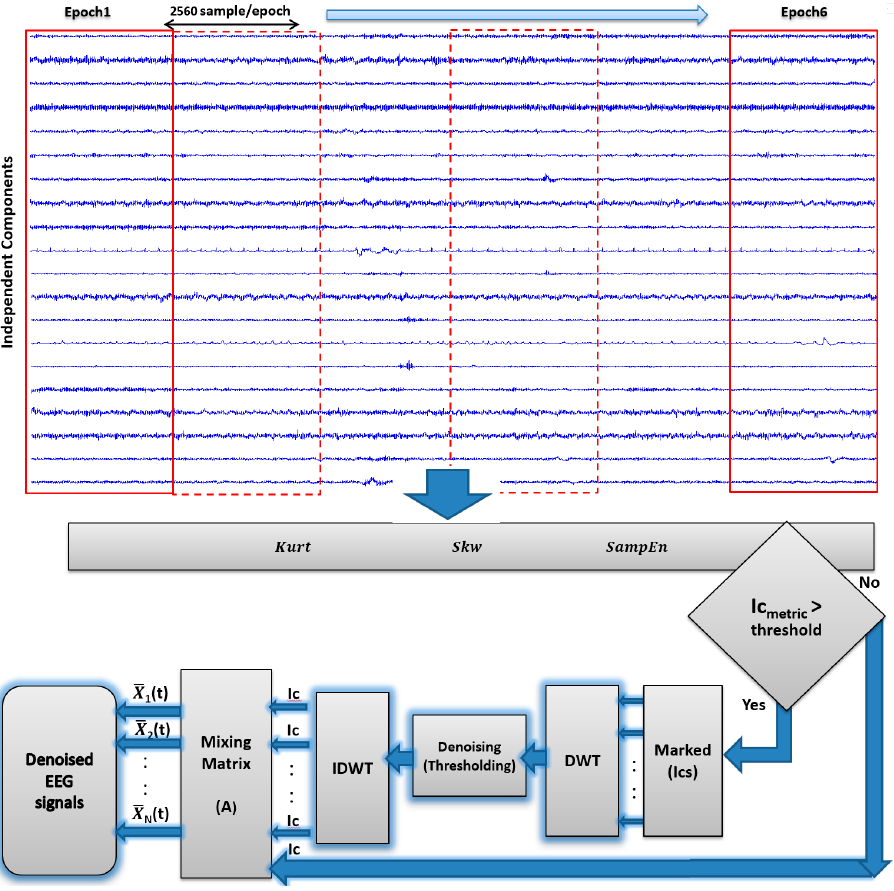
Figure 4. AICA–WT denoising technique.